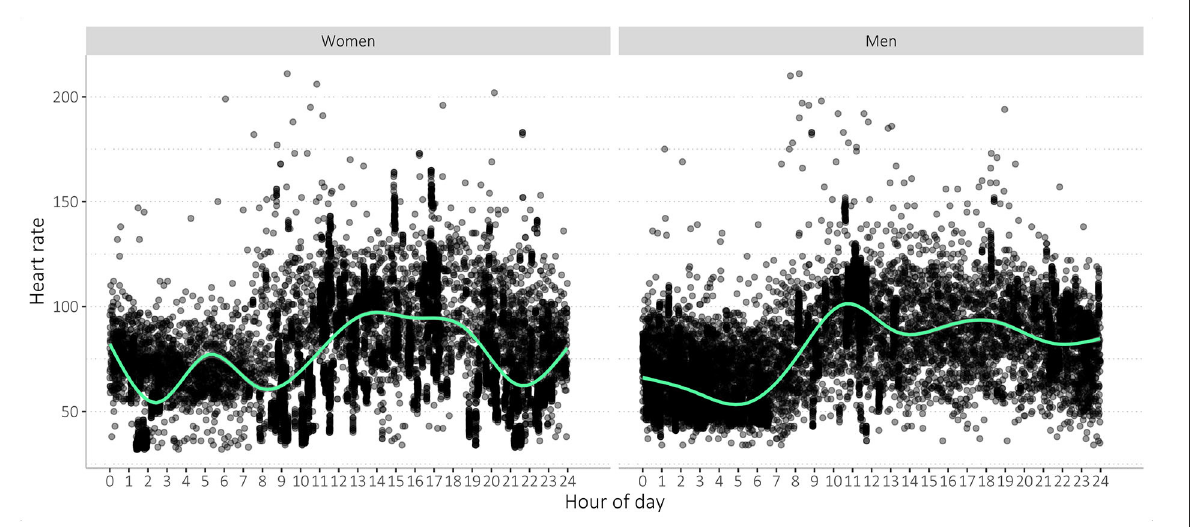
FIGURE9 Overview of participant’s heart rate measurements. As measured by the WPHR wearable device, all study participants over the full 9-week study period were displayed per gender. Measurements were widely variable, and the values were lower during the